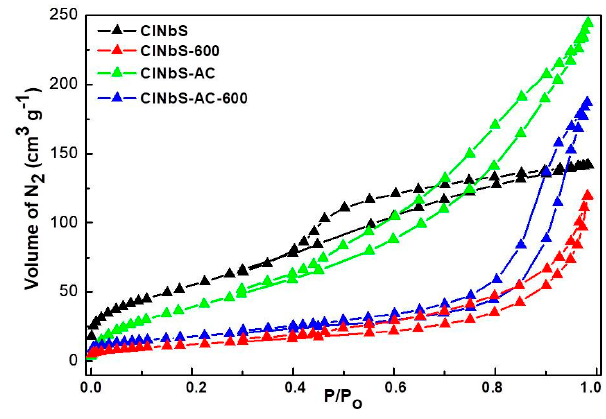
Figure 2. N 2 adsorption/desorption of the catalysts. Table 1. BET specific area values and pore volume by the BJH method for the synthesized catalysts.